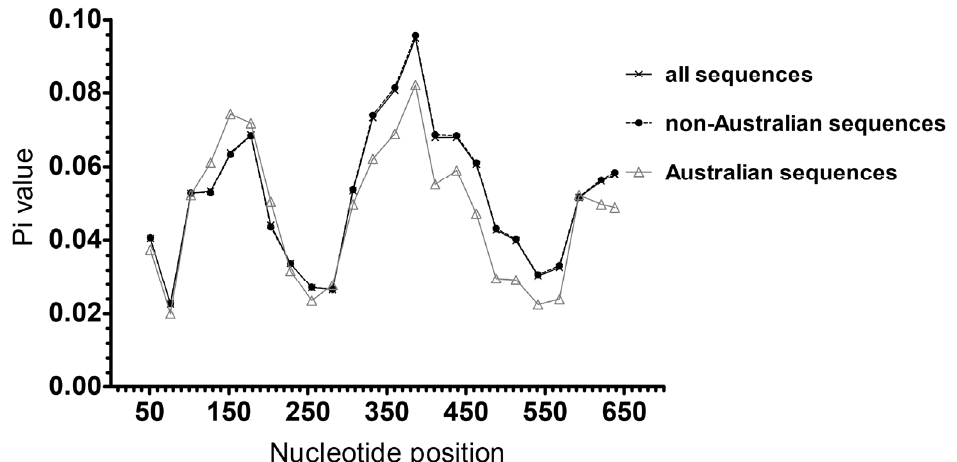
Figure 3. Nucleotide diversity (Pi) estimated over mid-point nucleotide position in the HBV surface gene from blood donors (window length of 100 bp and step size of 25 bp). The MAFFT-aligned sequences of surface gene were 681 bp in length.